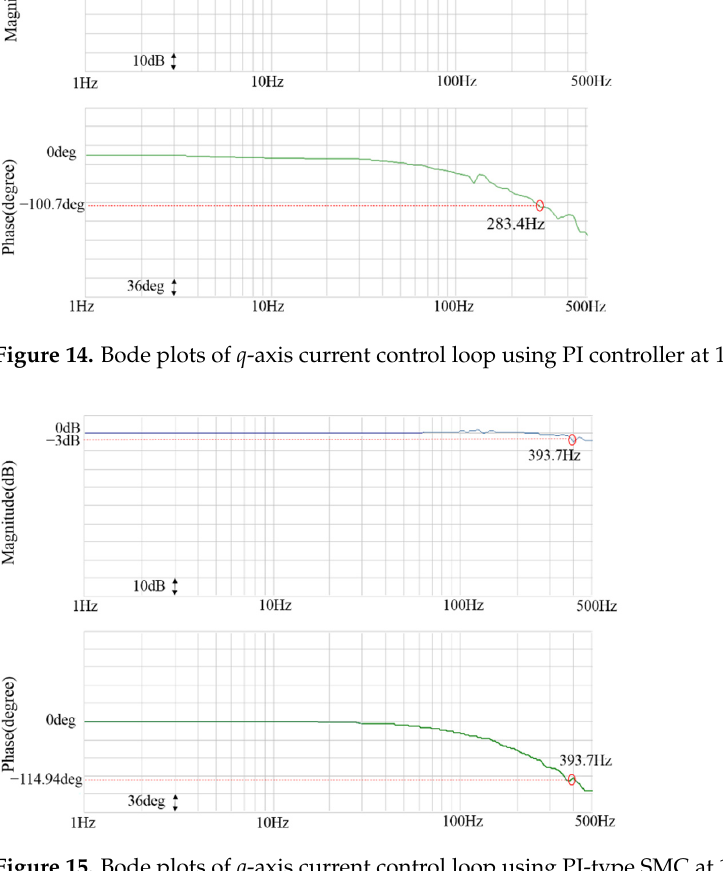
Figure 16. Bode plots of q -axis current control loop using PID neural network controller at 1000 rpm with 4.75 Nm.